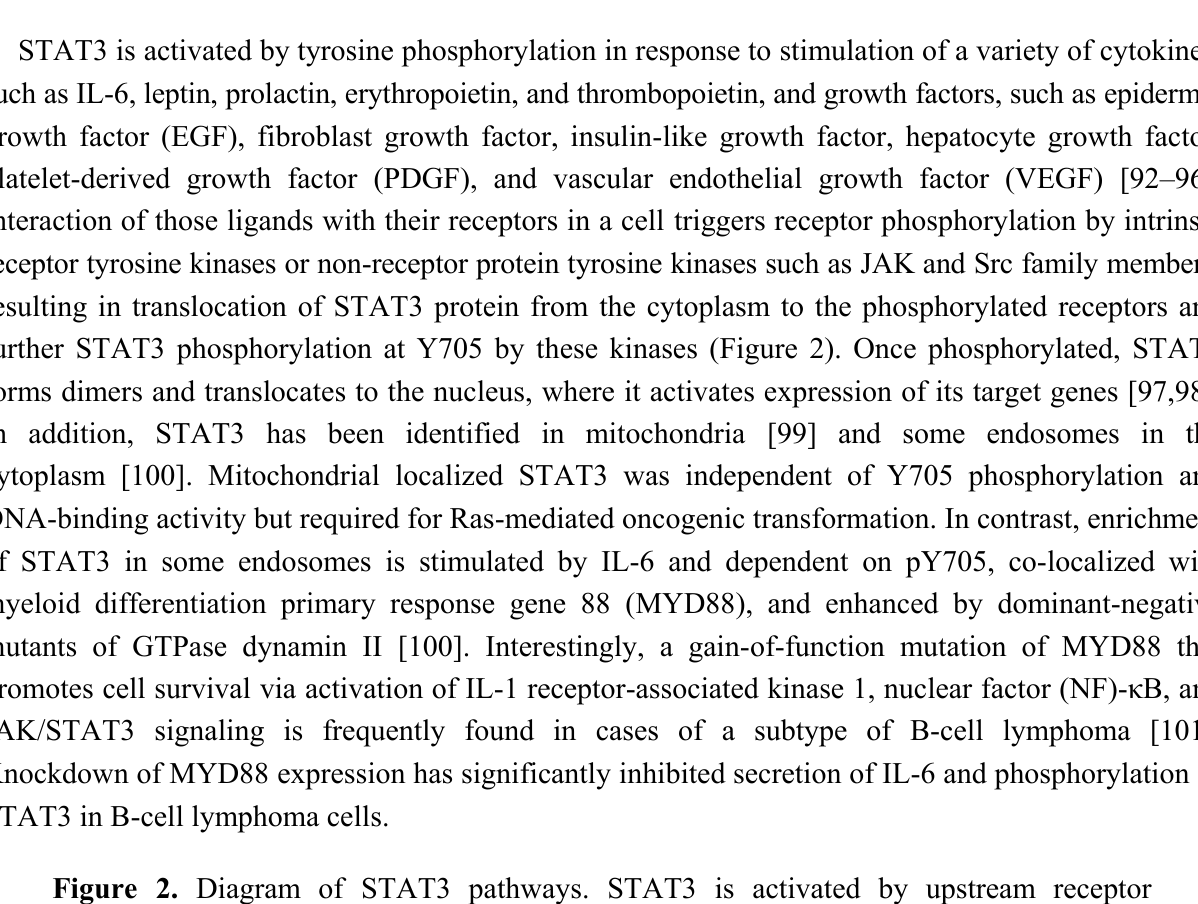
Figure 2. Diagram of STAT3 pathways. STAT3 is activated by upstream receptor tyrosine kinases, intracellular kinases, or histone acetyltransferases and regulates a diverse biological